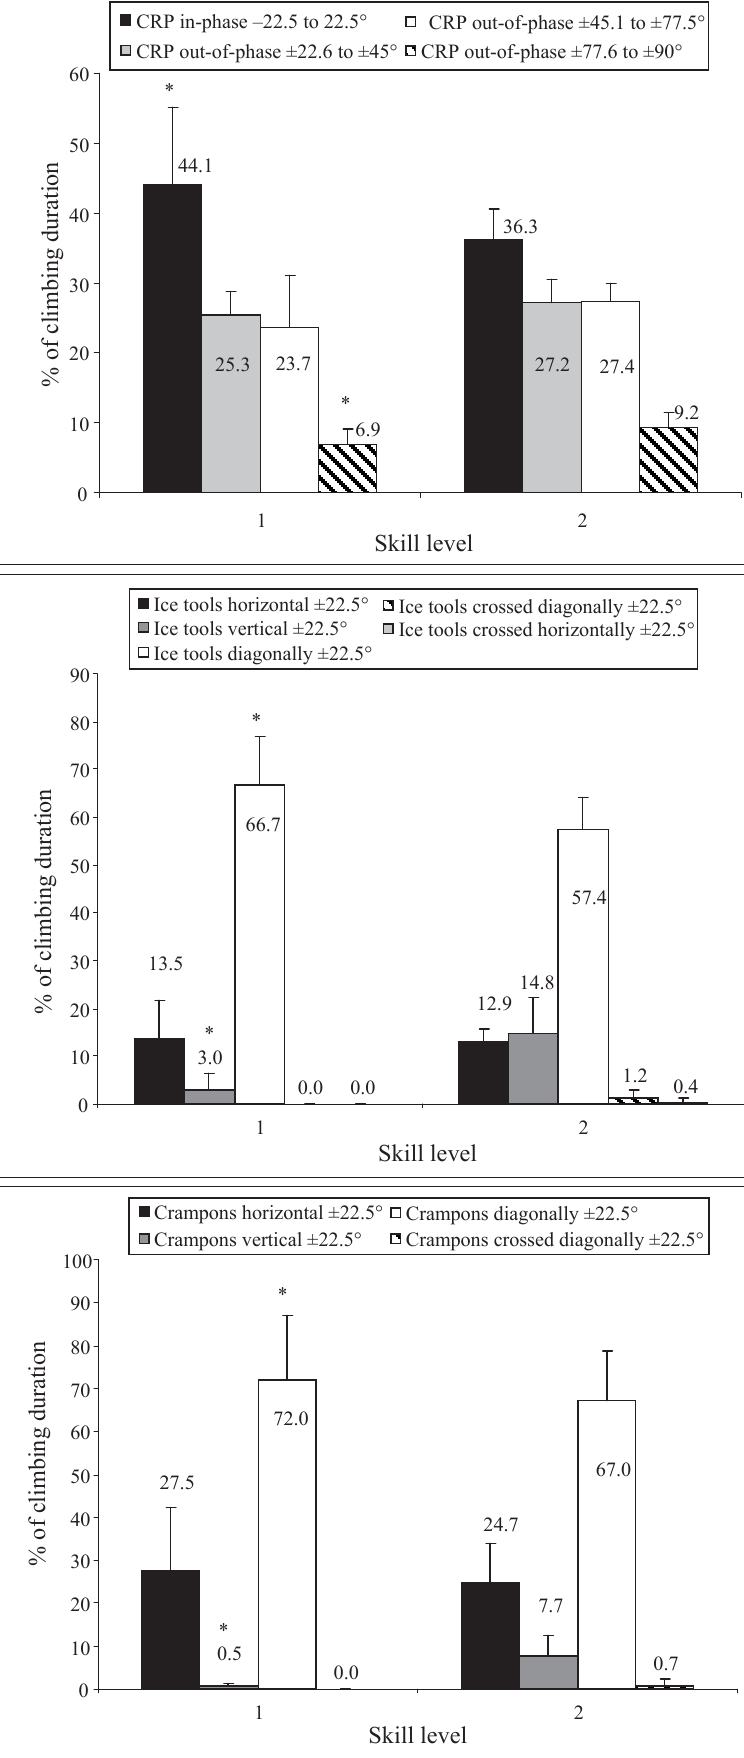
Figure 6. Time spent with the crampons in different angular